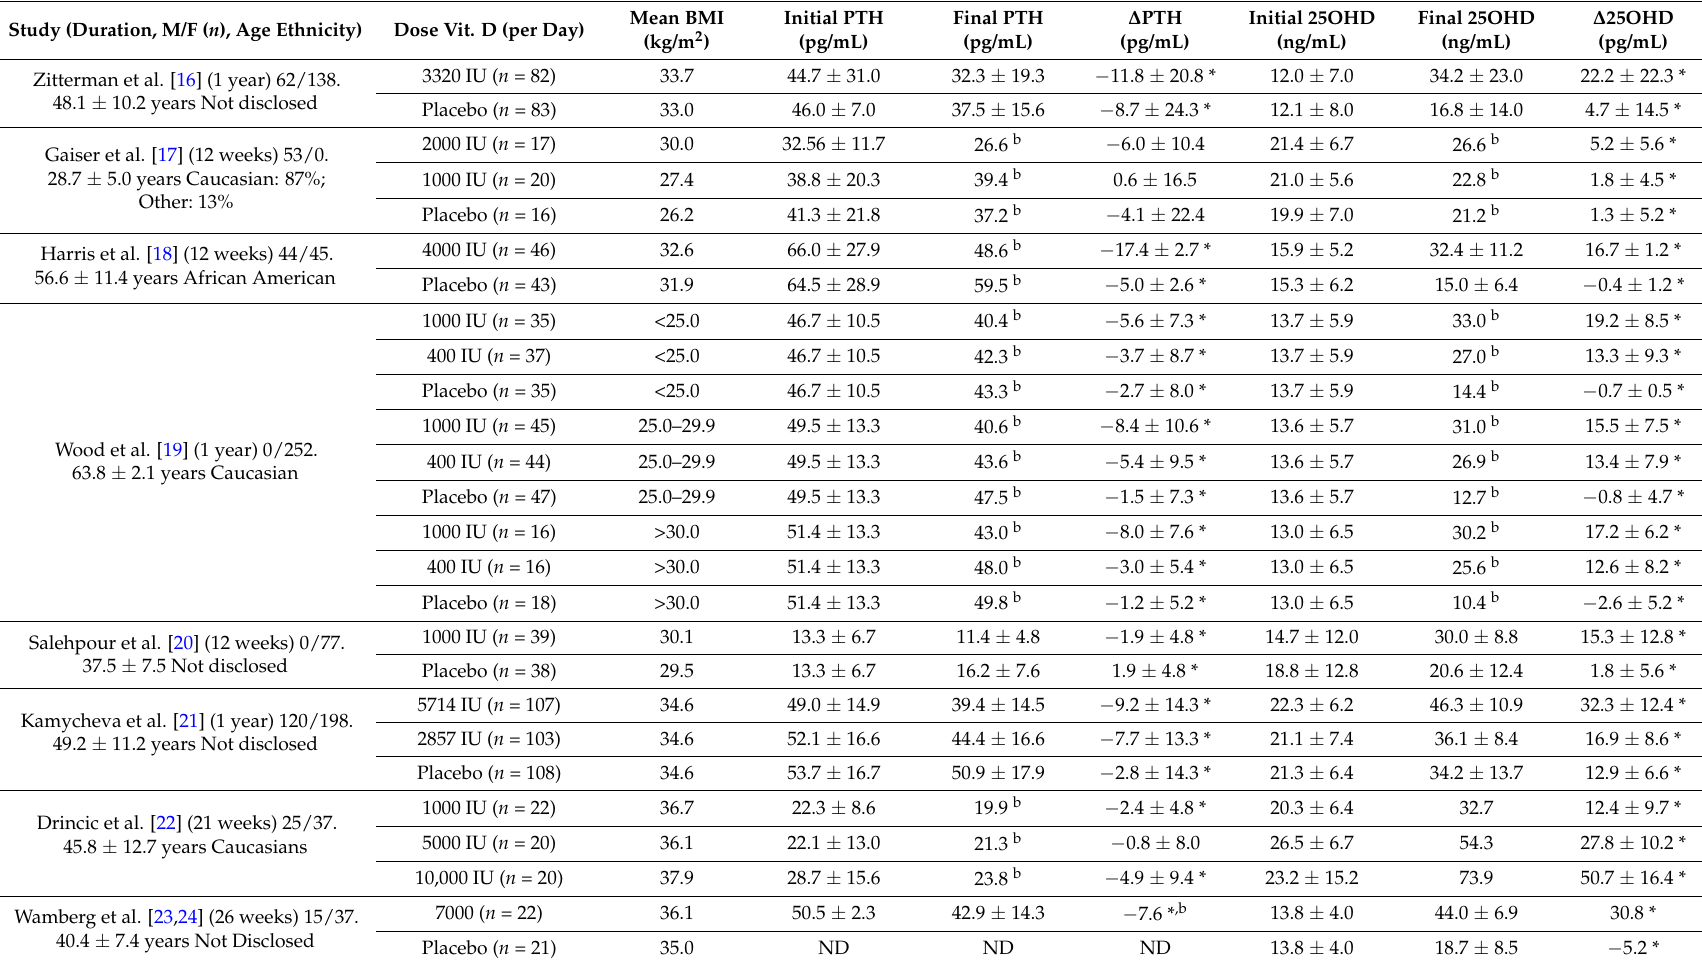
Table 1. Overview of vitamin D supplementation trials in overweight and obese populations a